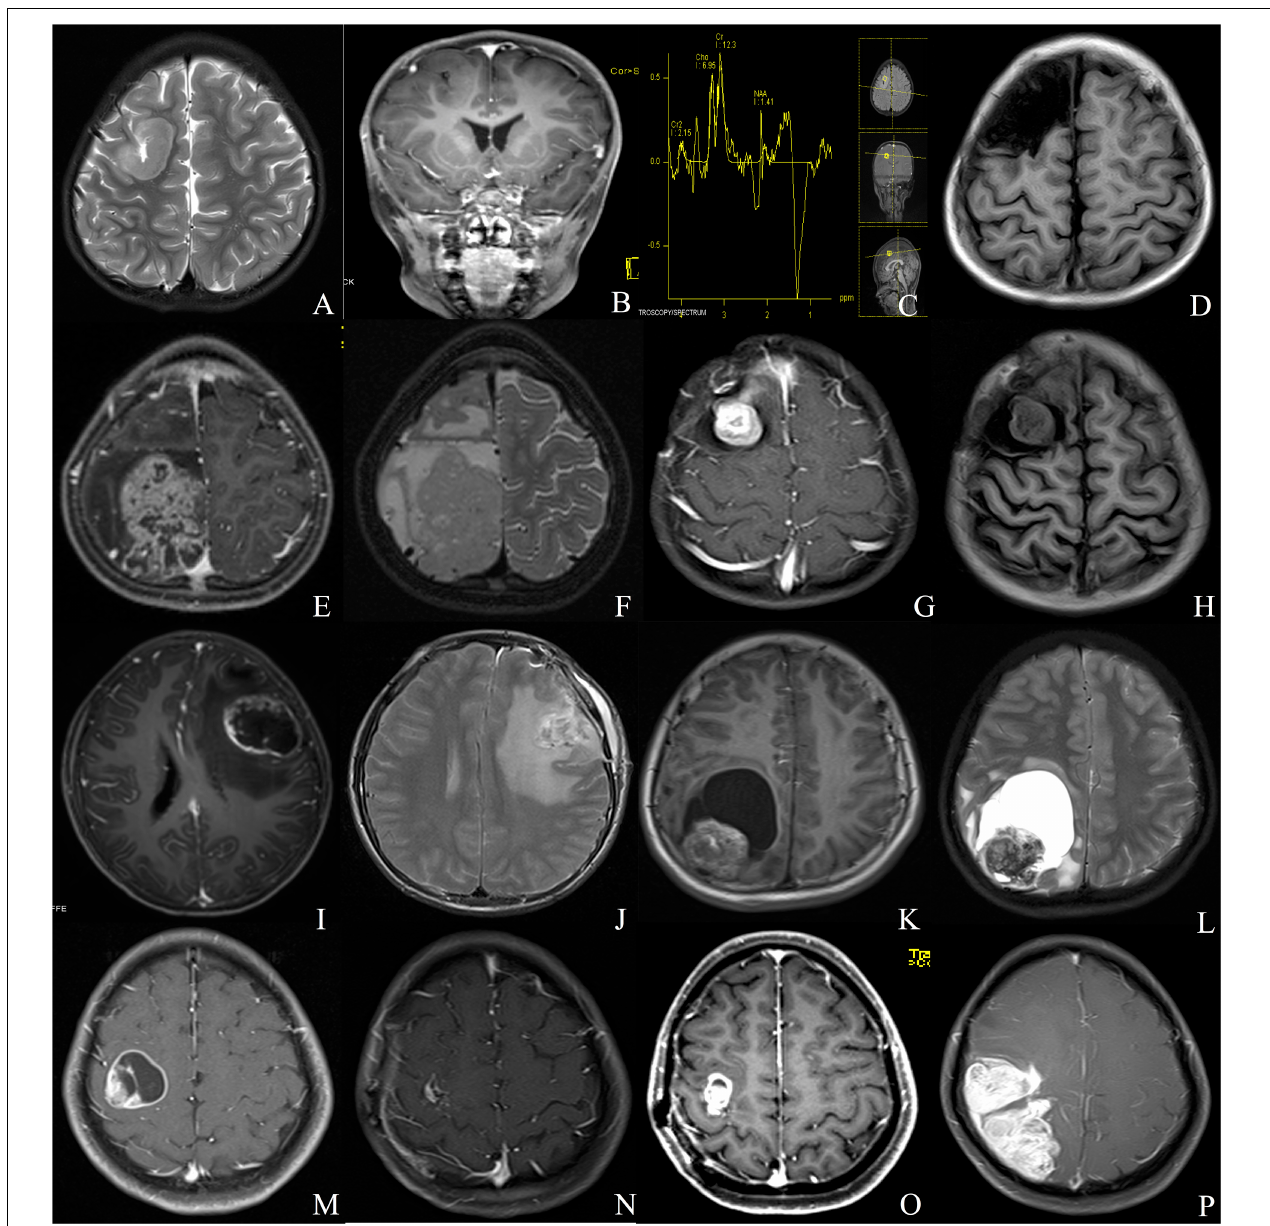
FIGURE 1 | Different radiologic characteristics of CEs. Case 1 (A–D) The tumor was found in the right frontal cortex (A) and showed no obvious enhancement (B) ; MRS depicted increased choline and decreased N -acetyl-aspartate (C) ; postoperative MRI scan showed total resection of the tumor (D) . Case 2 (E,F) A solid tumor with heterogeneous enhancement was depicted in the right parietal lobe. Case 3 (G,H) The tumor showed homogeneous enhanced solid appearance on MRI (G,H) . Case 4 (I,J) The tumor depicted a rim-enhanced cystic lesion with obvious peritumoral edema. Case 5 (K,L) The tumor demonstrated a solid mural with peritumoral cyst. Case 6 (M–P) The lesion showed rim-enhanced cystic lesion, without peritumoral edema (M) ; subtotal resection was applied due to the central region location of the tumor (N) ; the tumor recurred 1 year after the surgery (O) , and the lesion continued to grow during the follow-up (P)